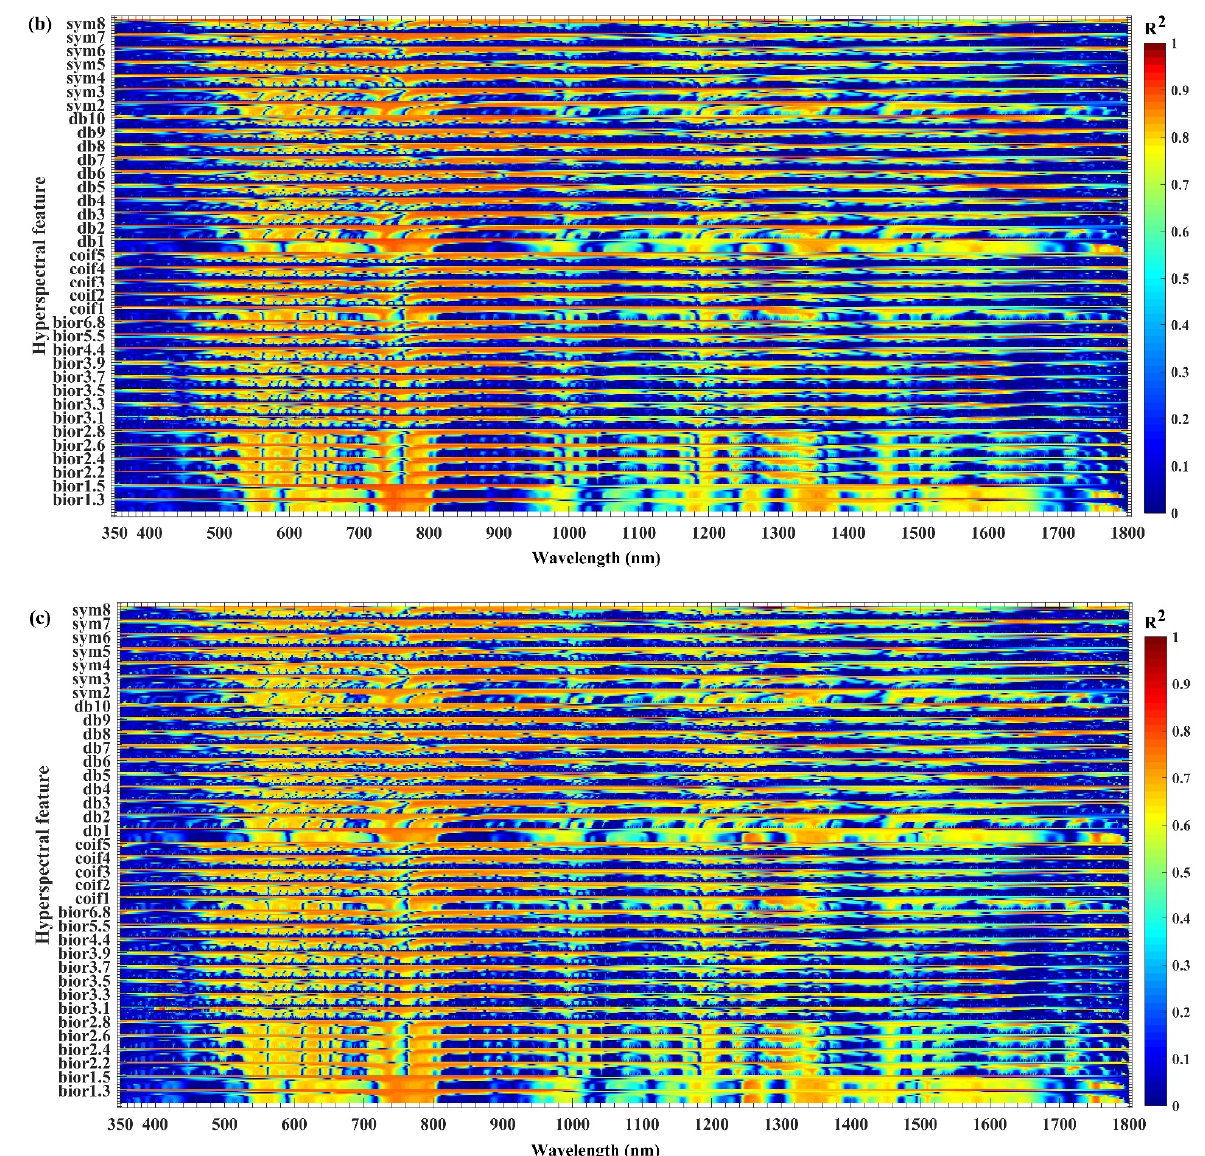
Figure 4. Variations of R 2 (the correlation coefficient r squared) with wavelength between the spectral continuous wavelet coefficients and: ( a ) chlorophyll content ( b ) fresh weight moisture content; and ( c ) dry weight moisture content.